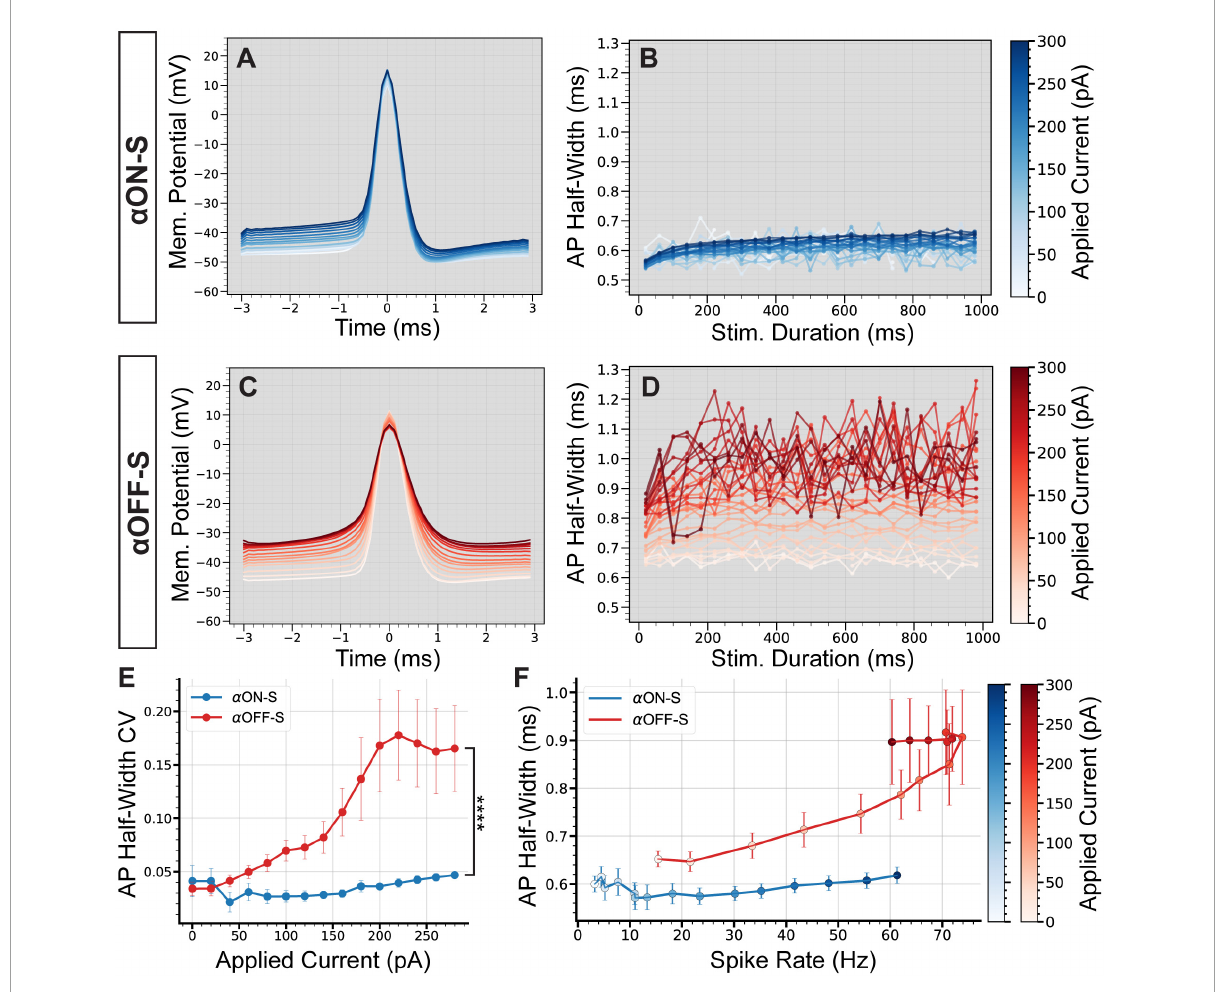
FIGURE3 Cell type-specific differences in firing dynamics are reflected in the action potential shape. (A) Mean action potential (AP) shapes for alpha ON-sustained ( α ON-S) cells at each current step. (B) Mean AP half-width vs. stimulus duration for each current level of α ON-S cells. (C) Mean AP shapes for alpha OFF-sustained ( α OFF-S) cells at each current step. (D) Mean AP half-width vs. stimulus duration for each current level of α OFF-S cells. (E) AP half-width coefficient of variation (CV) vs. applied current for α ON-S and α OFF-S cells. As depolarization increases, the variability of AP width increases significantly more for α OFF-S cells than α ON-S (Mixed effects analysis interaction between current and cell type, p < 0.0001). (F) The mean spike rate at each current injection vs. the AP half-widths. α OFF-S retinal ganglion cells (RGCs) demonstrate significant rate-dependent spike widening (simple linear regression, non-zero slope p < 0.0001) while α ON-S RGCs do not ( p = 0.0668). Error bars = mean ± standard error of the mean. **** p < 0.0001.